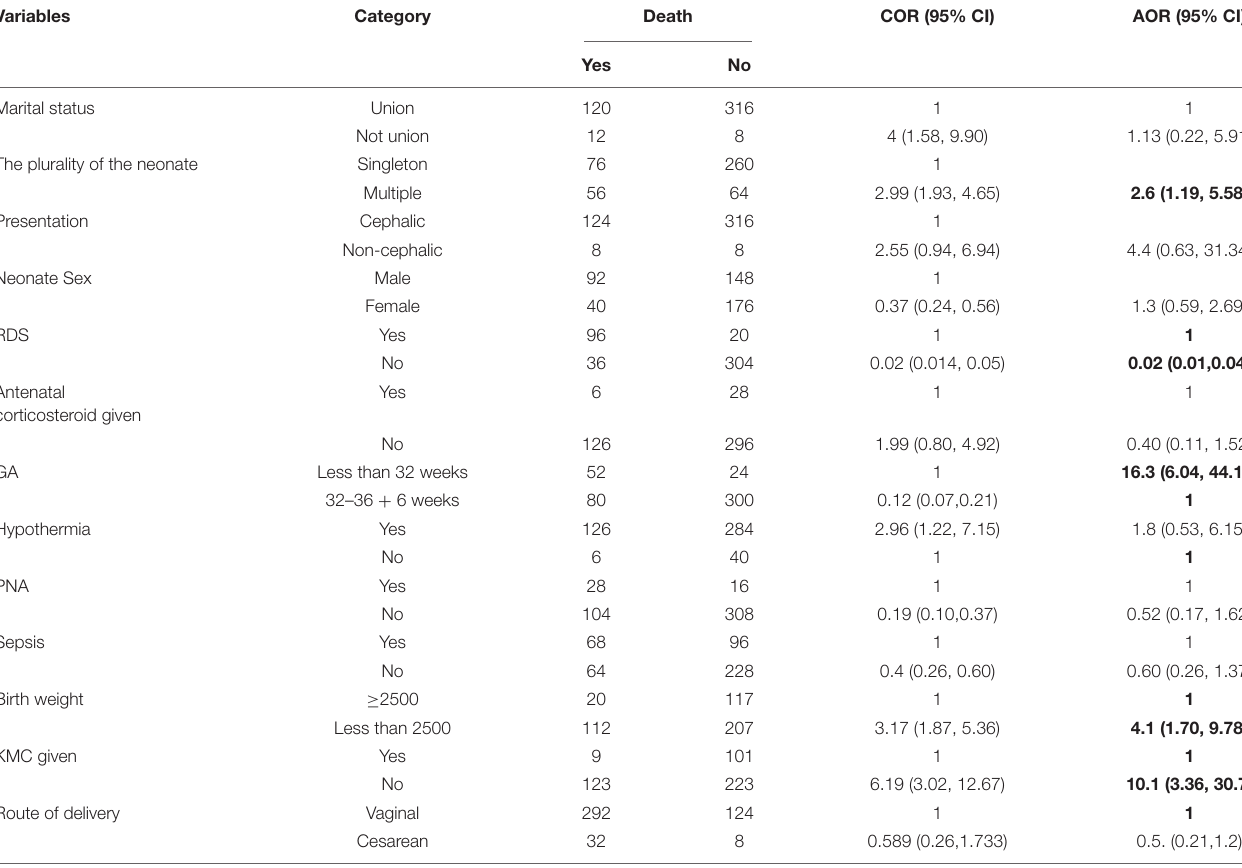
TABLE 5 | Multivariate binary logistic regression results among preterm neonates in south Gondar zone public hospitals, North West Ethiopia, 2021. Variables